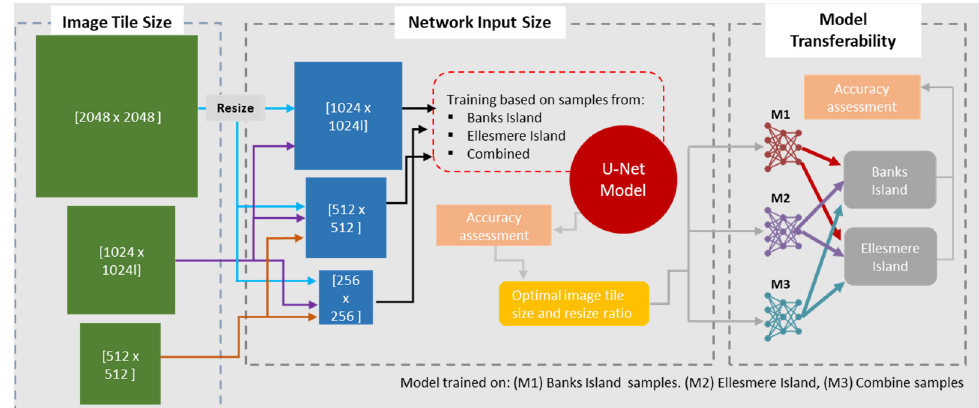
Figure 3. A simplified schematic of the overall experimental design.